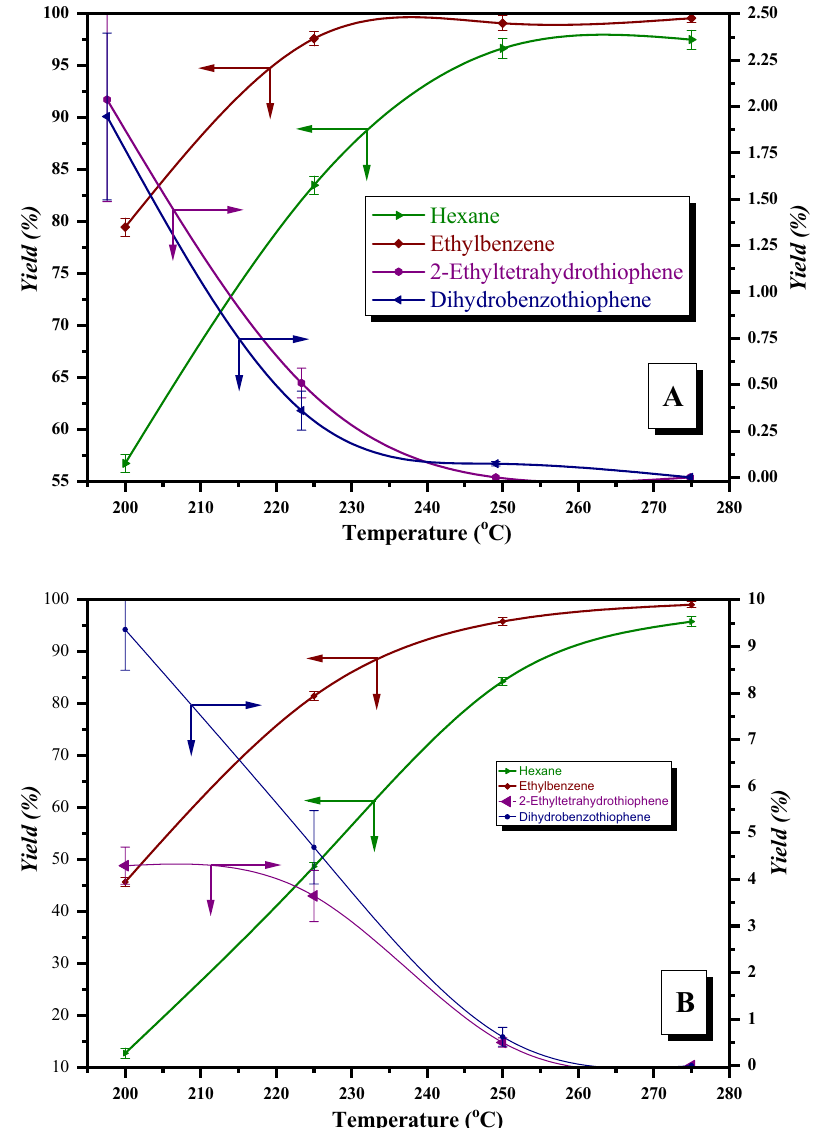
Figure 10. Product yields with temperature over CoMo/γ-Al 2 O 3 ; ( A ) single sulfur compound HDS (T, 2-ET, BT); ( B ) mixture of sulfur compounds HDS (T + 2-ET +